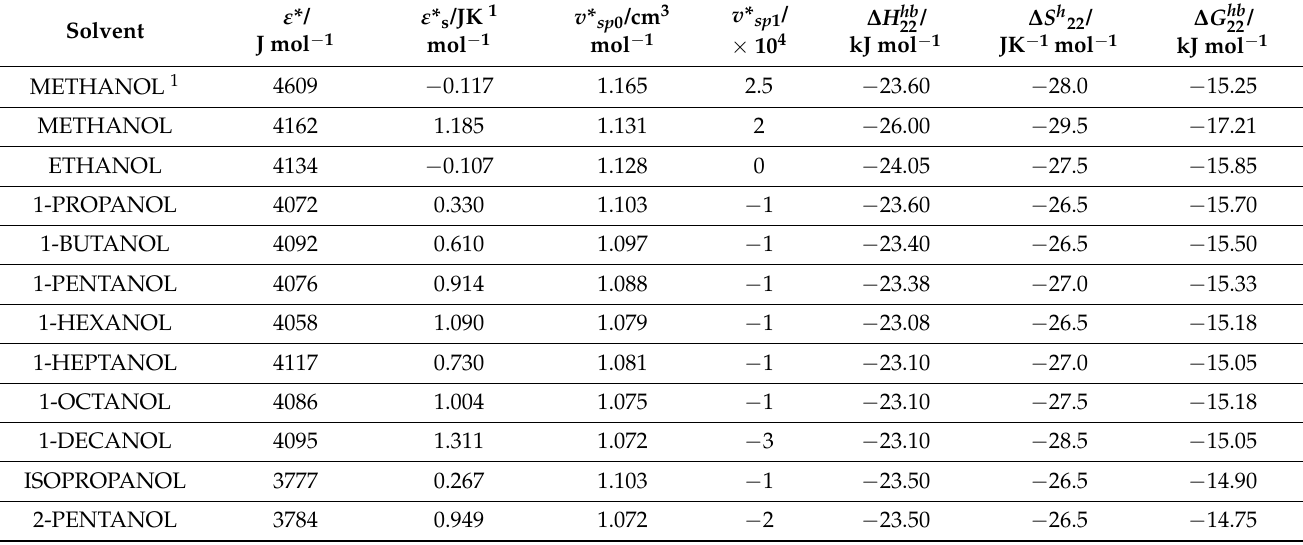
Table 2. The scaling constants and the hydrogen bonding solubility parameters of